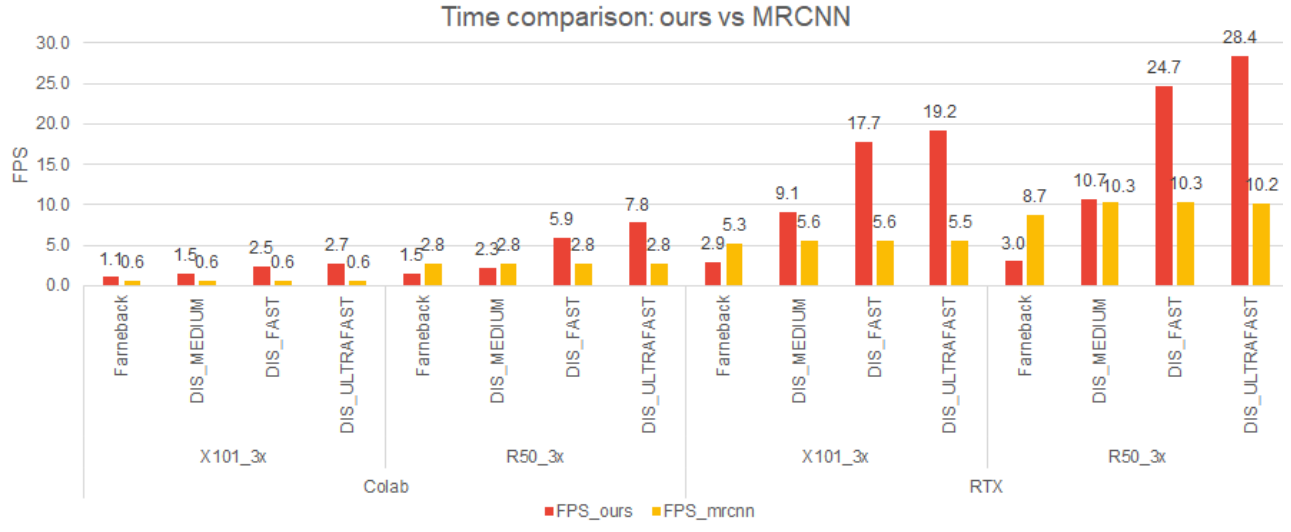
Figure 10. Time—Cityscapes dataset [2], RTX and Colab platforms.